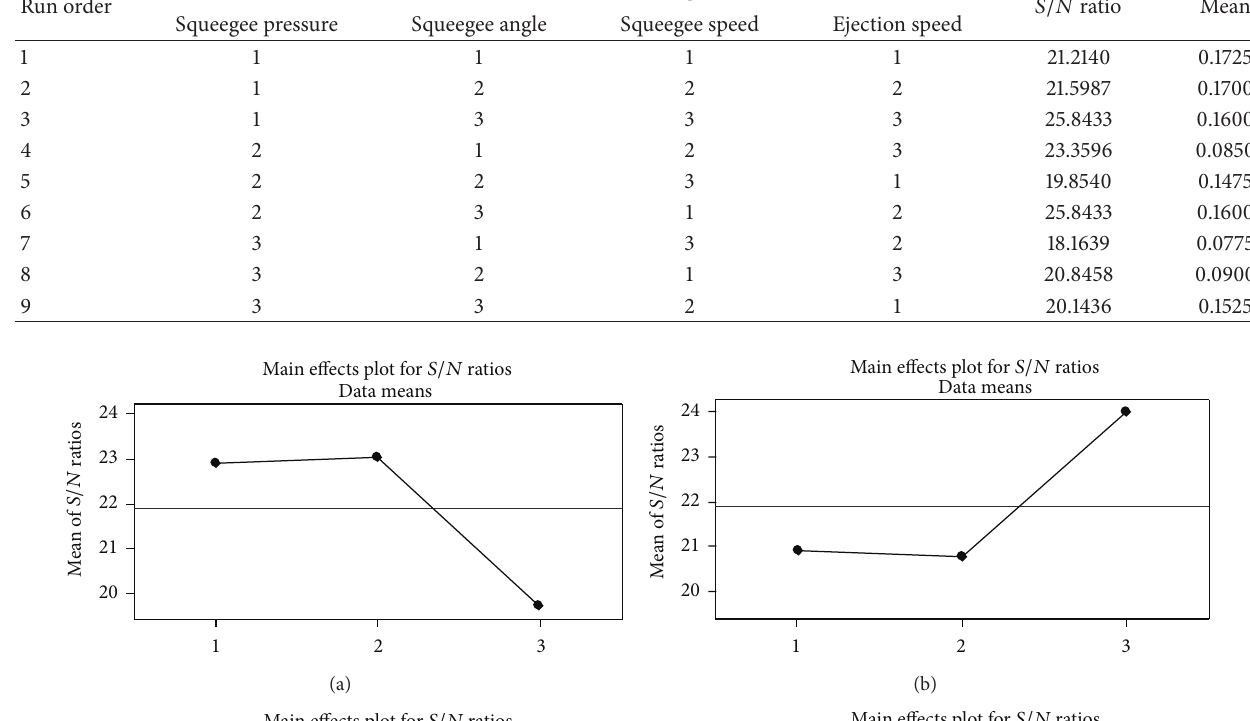
Table 2: Experimental design using the L